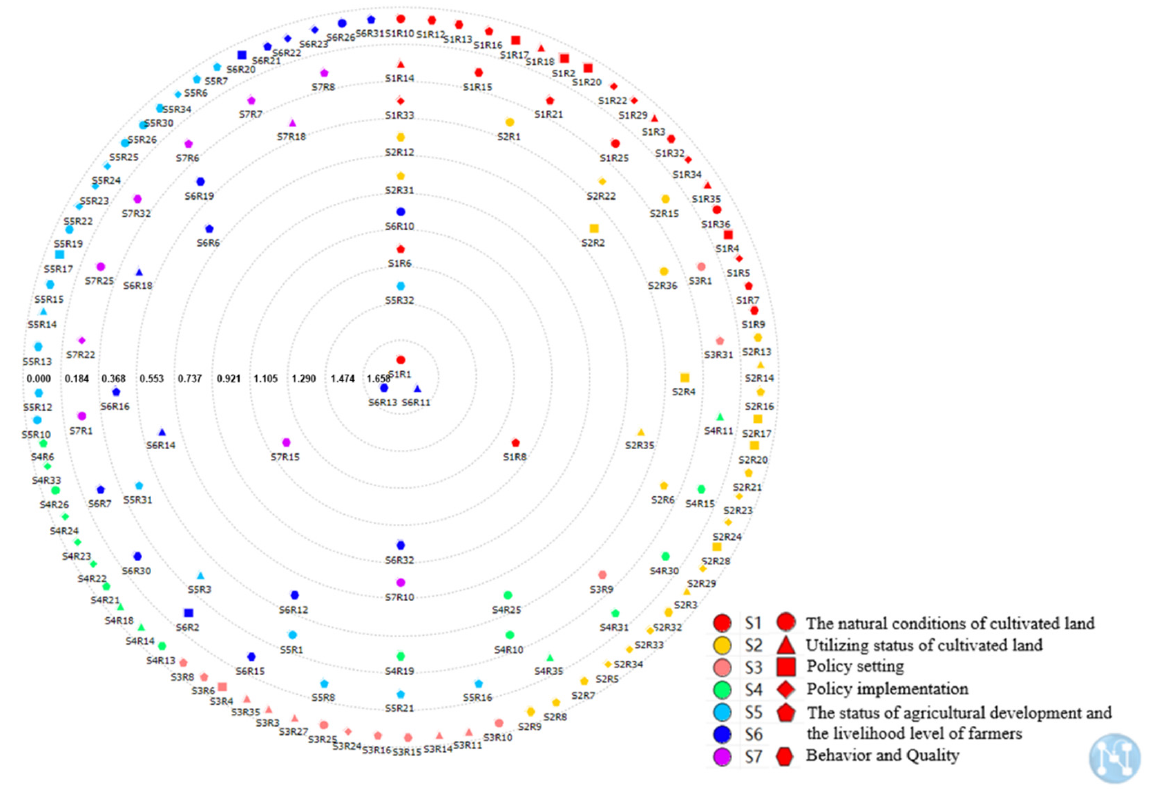
Figure 4. Distribution of risk factors in terms of the status centrality. Note: S1, village committee; S2, local government; S3, land-use organization; S4, land non-flow farmers; S5, land flow-in farmers; S6, land flow-out farmers; and S7, the public.